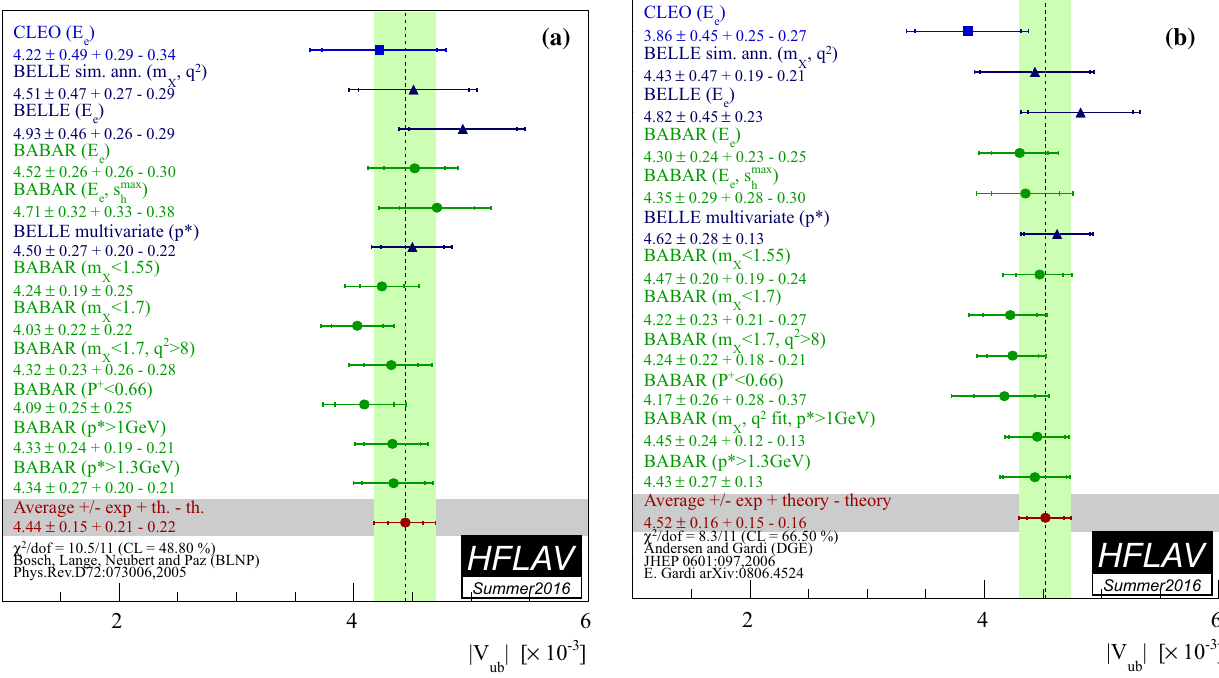
Fig. 63 Measurements of | V ub | from inclusive semileptonic decays and their average based on the BLNP ( a ) and DGE ( b ) prescription. The labels indicate the variables and selections used to define the signal regions in the different analyses